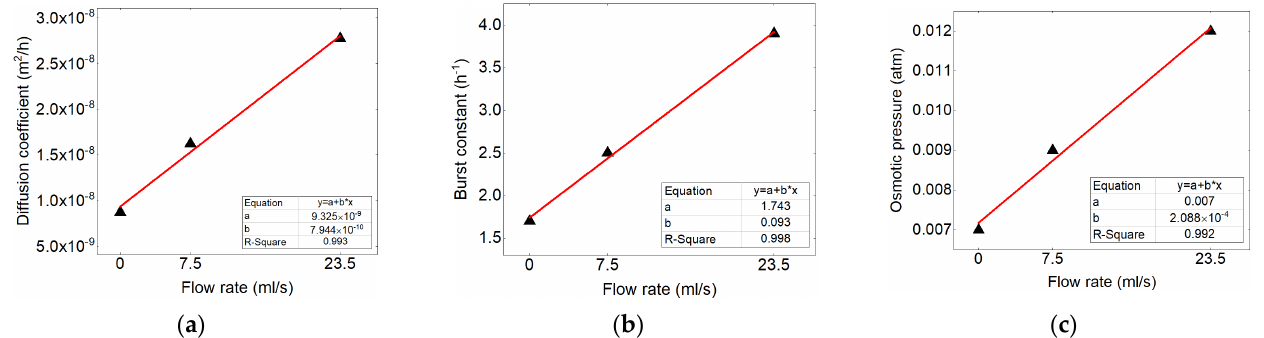
Figure 12. Correlation between ( a ) diffusion coefficient, ( b ) burst constant, ( c ) osmotic pressure in accordance to the flow rate adapted to the linear equation.